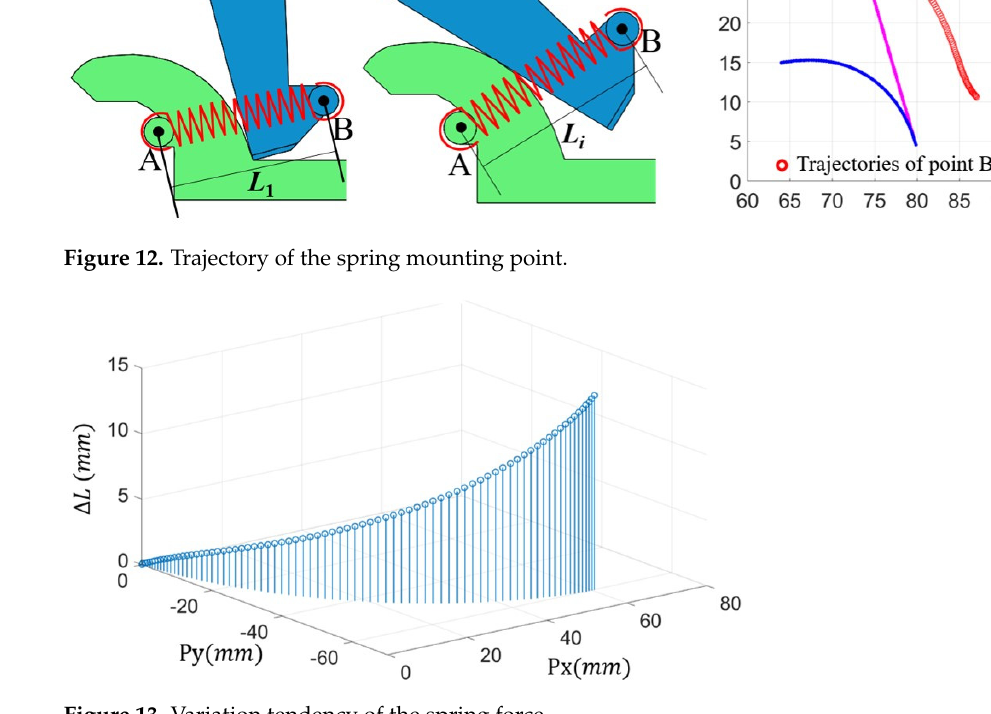
Figure 13. Variation tendency of the spring force.